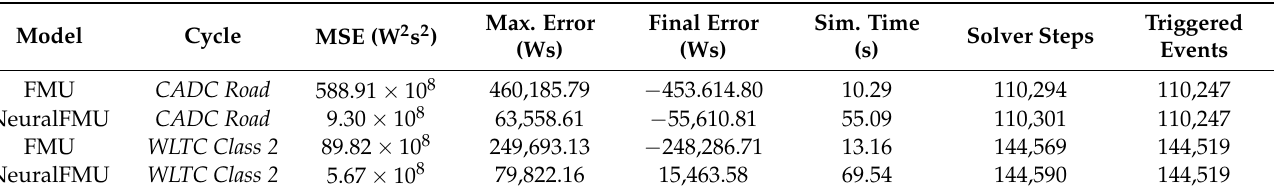
Table 2. Training and testing results with solver Tsit5 after 18 training epochs. Errors are calculated against the data mean of two chassis dynamometer